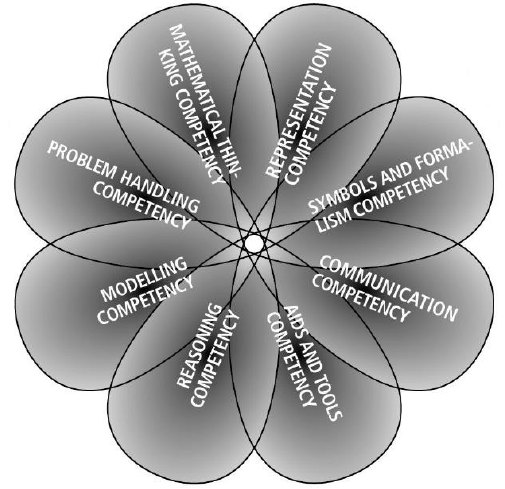
Figure 1. The so-called KOM